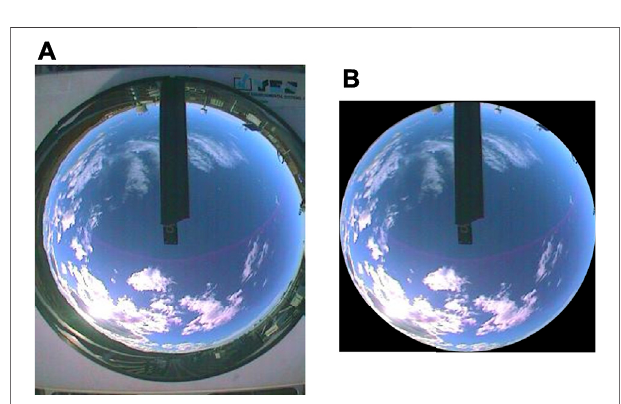
FIGURE 2 | Redundancy reduction of the sky image for irradiance (A) original and (B) after reduction.